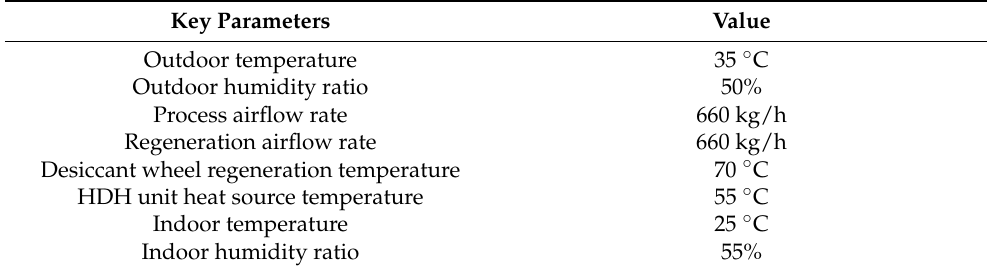
Table 2. Initial working conditions of the